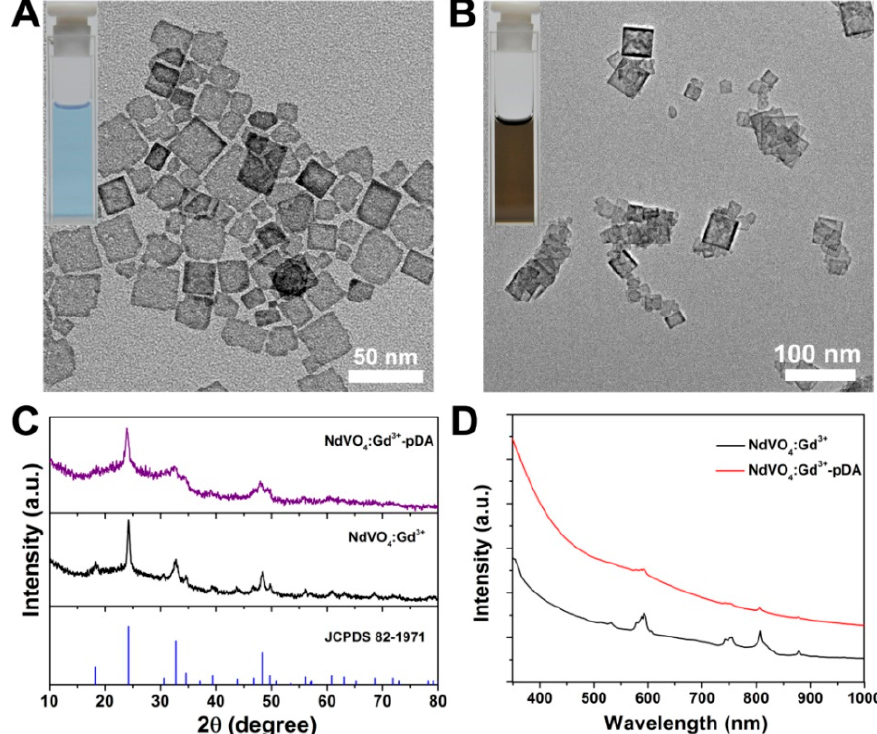
Figure 1. TEM images of NdVO 4 :Gd 3+ ( A ) and NdVO 4 :Gd 3+ -pDA nanoplates ( B ); inset: the digital photos of NdVO 4 :Gd 3+ in cyclohexane and NdVO 4 :Gd 3+ -pDA in DMSO, respectively. ( C ) XRD patterns of NdVO 4 :Gd 3+ samples, NdVO 4 :Gd 3+ -pDA nanoplates, and the standard JCPDS card no. 82-1971. ( D ) Emission spectrum of NdVO 4 :Gd 3+ -pDA nanoplates under excitation of 808 nm laser light.